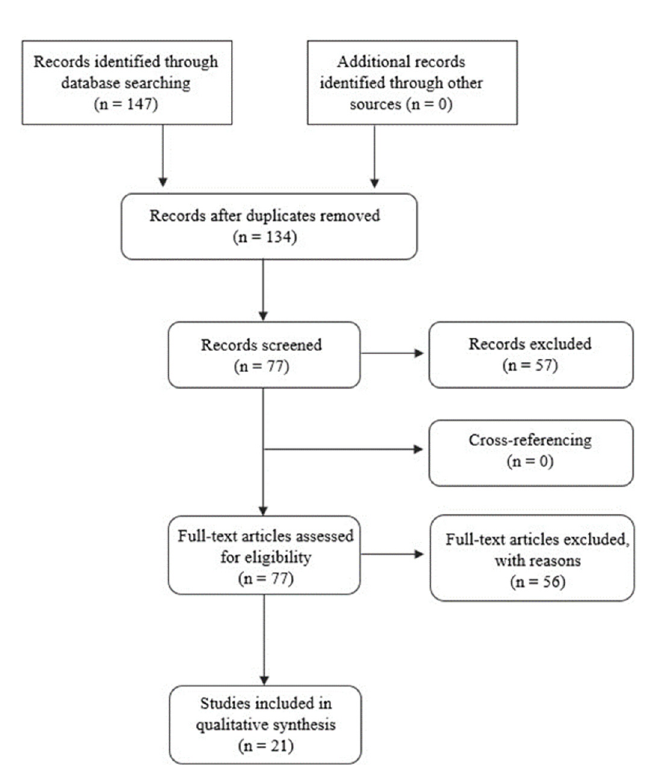
Figure 3. Prism of the systematic review, where the literature searches in the database are detailed, the number of articles selected based on the abstract, the number of articles evaluated by the eligibility criteria, and the total number of articles included in the review.